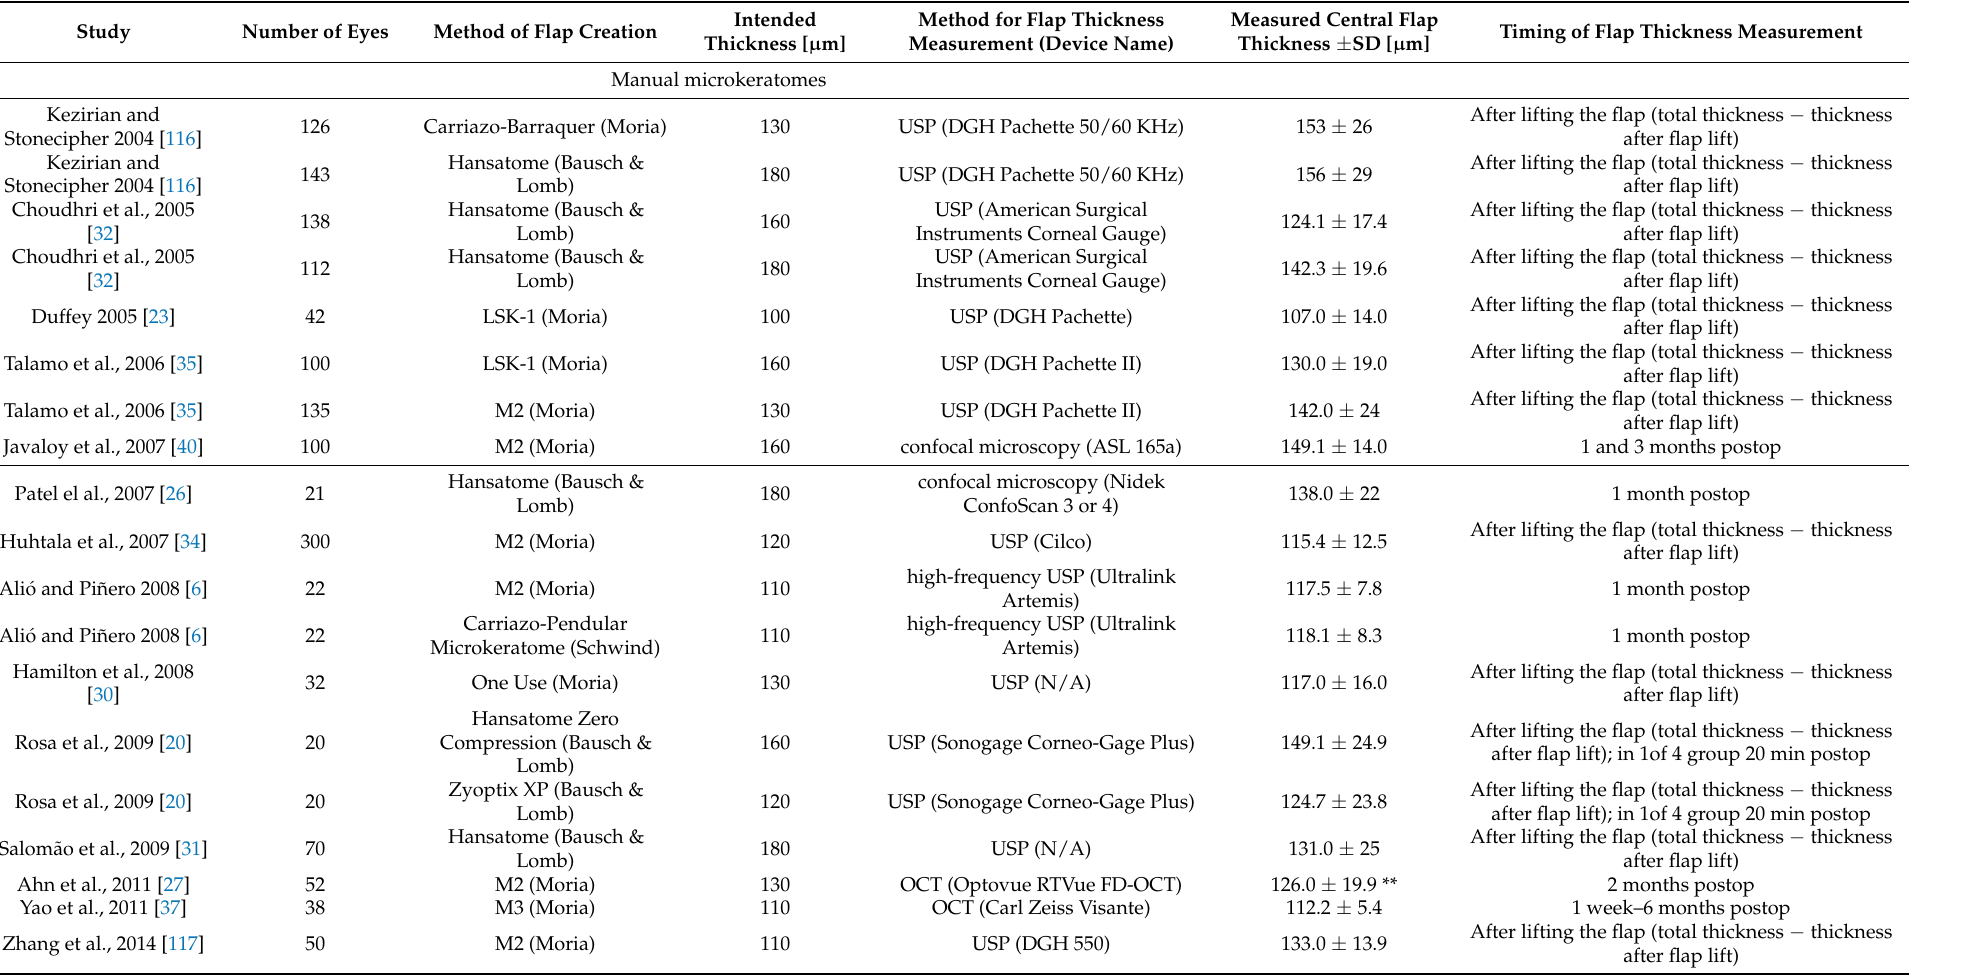
Table A1. Flap thickness obtained with manual and femtosecond methods for corneal flap creation in clinical LASIK